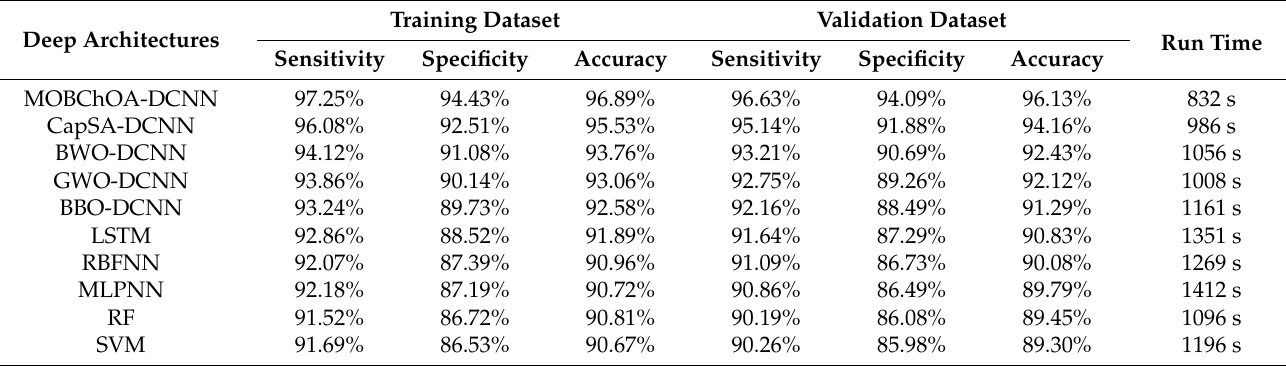
Figure 13. Some flat surfaces inside the vegetation. Table 6. Algorithm results for the validation of classified images.